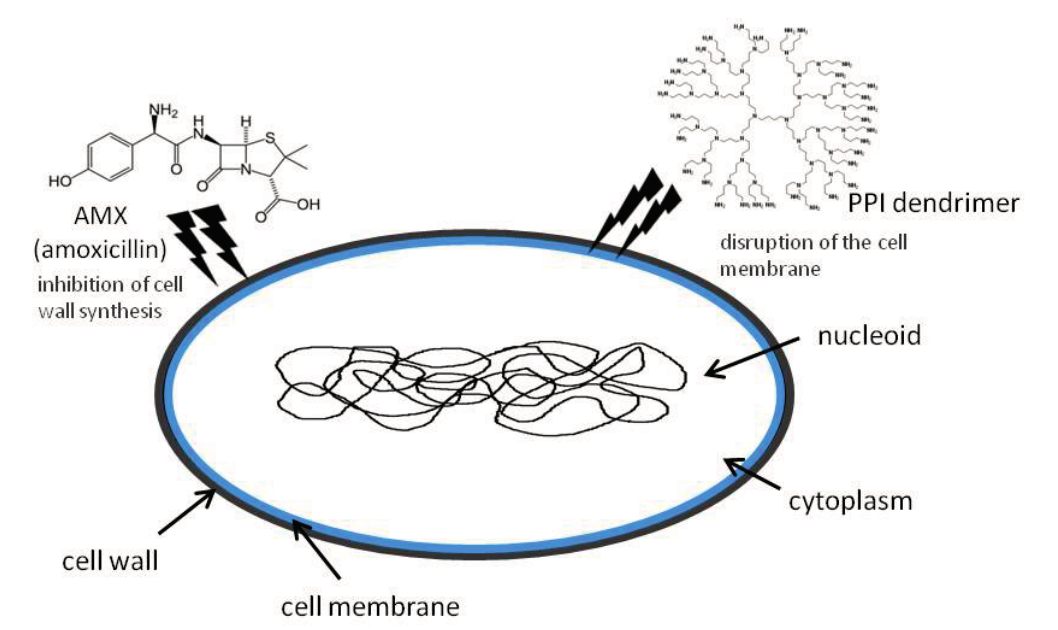
Figure 7. Mechanism of antibacterial activity of PPI dendrimers and